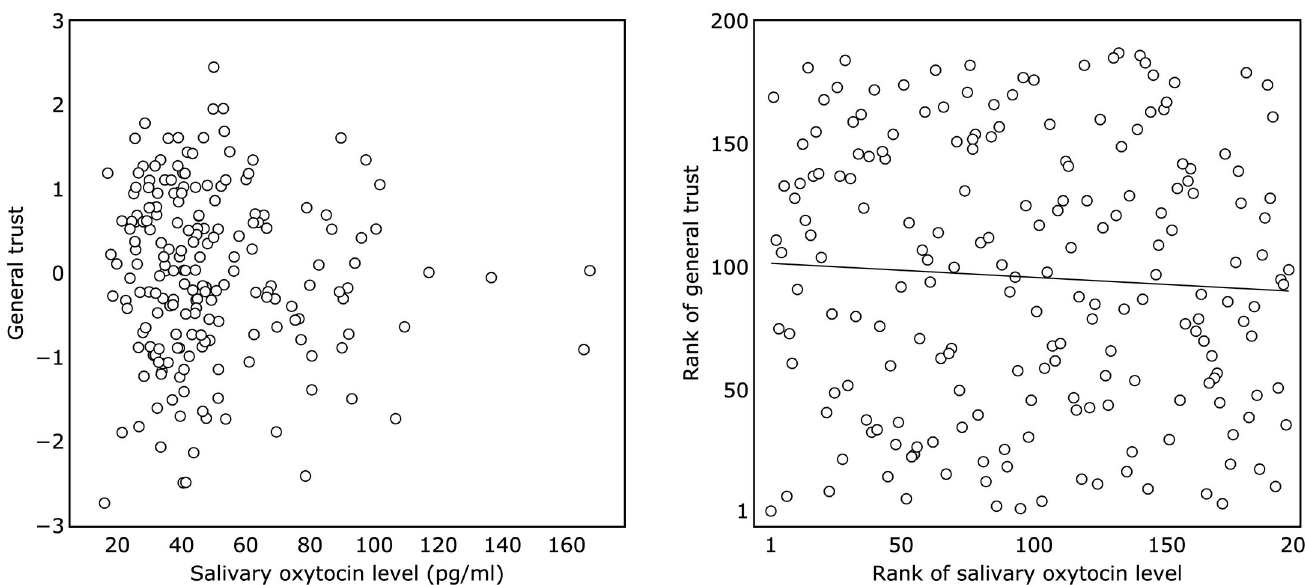
Fig 2. The association between salivary oxytocin level and general trust. (A) scatter plot of salivary oxytocin level and general trust. (B) scatter plot of rank of salivary oxytocin and rank of general trust.